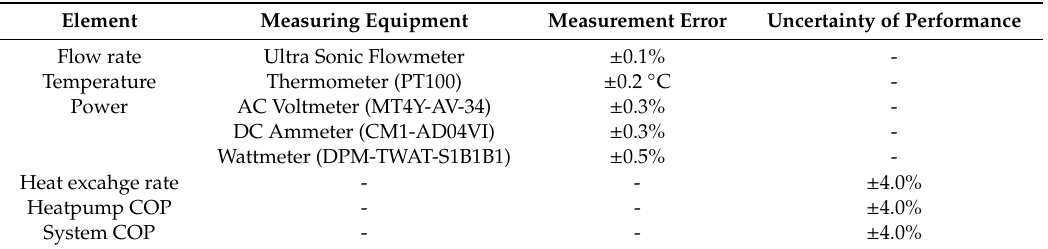
Table 3. Measurement errors of the measuring equipment. COP: coe ffi cient of performance.